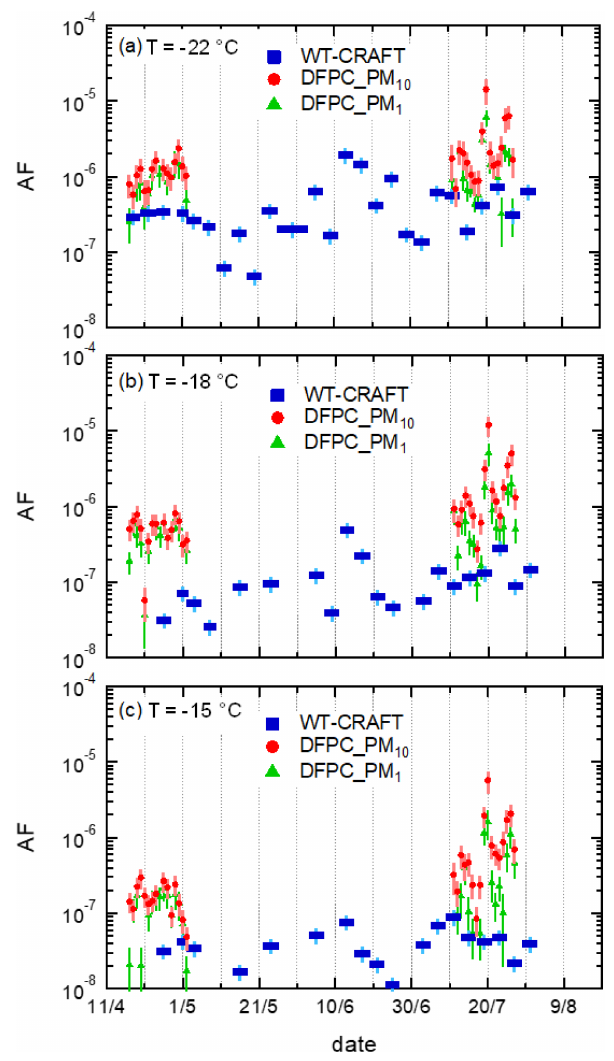
Figure 5. Time series of the activated fraction at GVB during 2018 measured by DFPC (PM 10 and PM 1 ) and WT-CRAFT. Horizontal bars indicate the period of WT-CRAFT samples (ca. 4d for the ma- jority of samples). Vertical bars indicate the overall AF uncertainty as indicated in Sect. 2.2.1 (DFPC) and 2.2.2